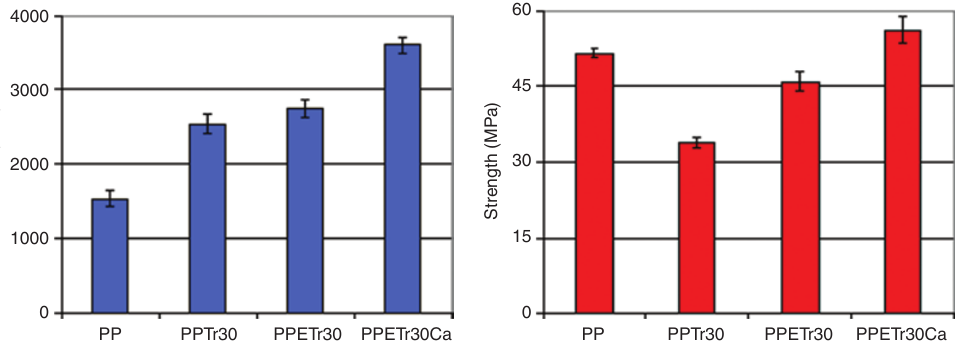
Figure 8 Flexural properties of PP triticale composites with different